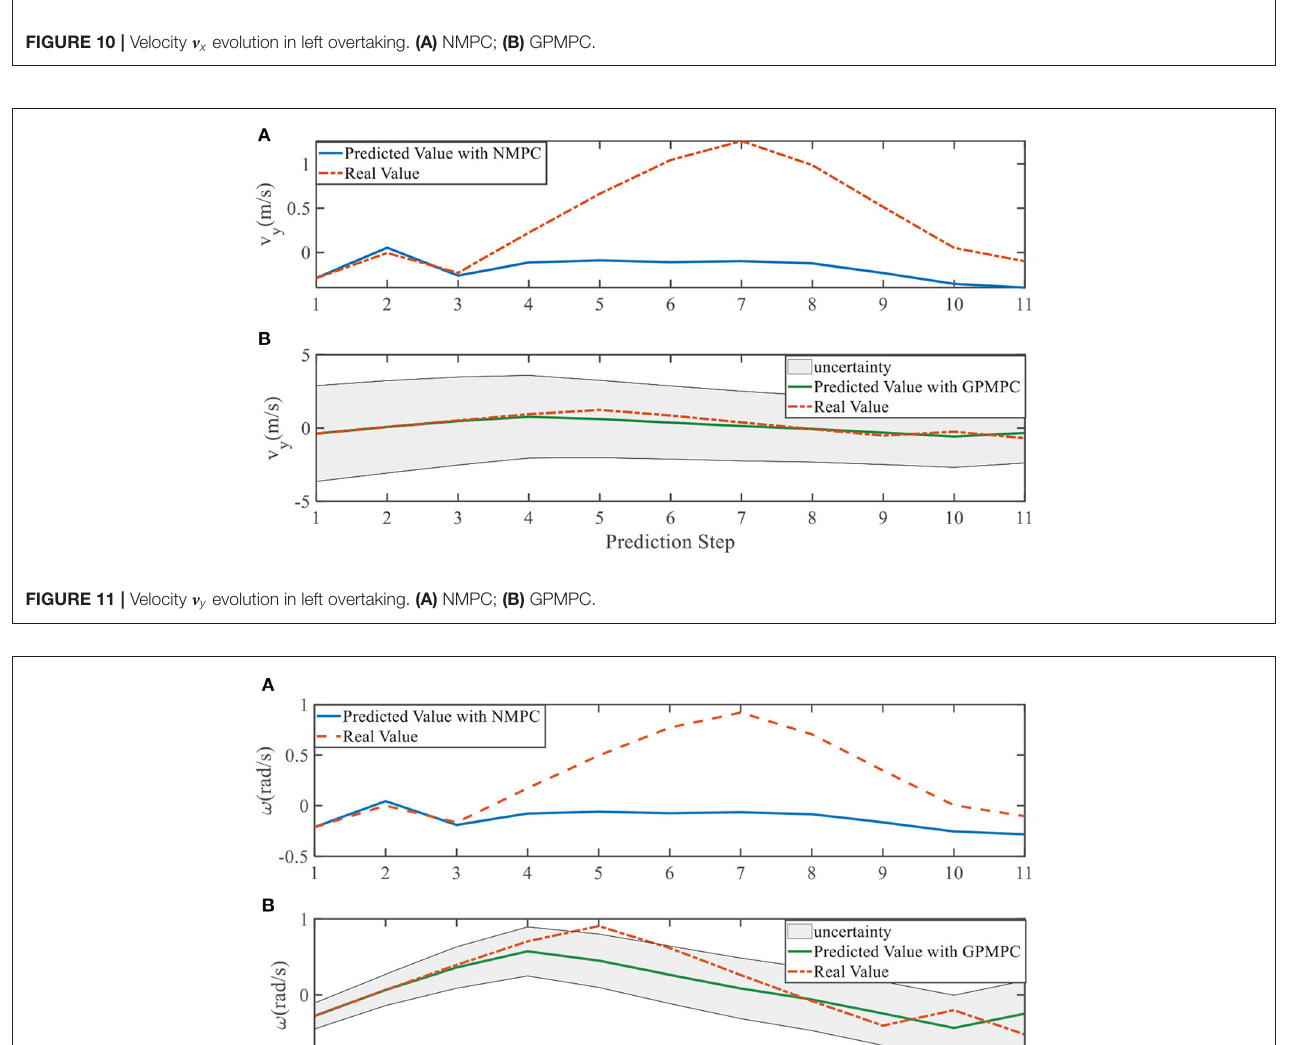
Frontiers in Neurorobotics |